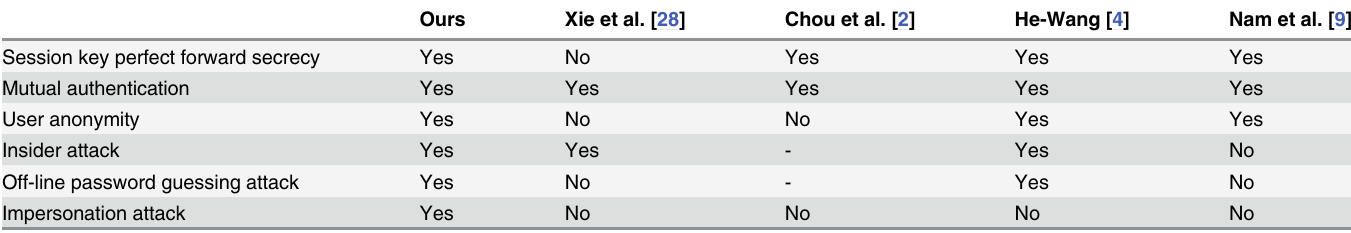
Table 4. Security properties